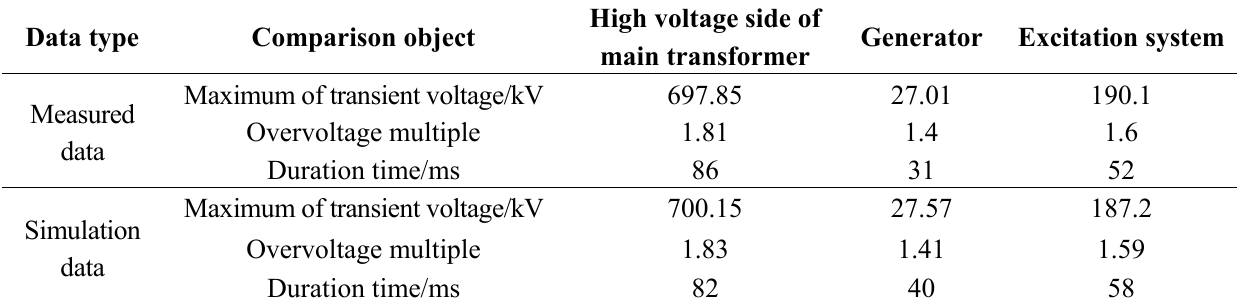
Table 4. Data comparison of charging the unloaded line